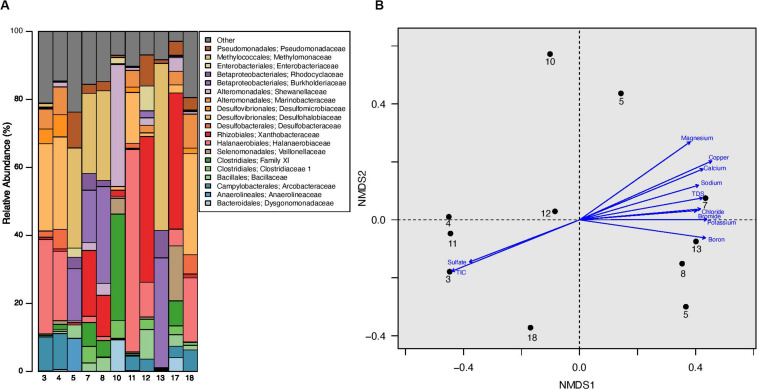
(A) Relative abundance of microbial families in produced water samples obtained from well separators. All families that represent = 5% of sequences from any one sample are listed in the barplot, all other families are grouped together under “Other.” (B) Non-metric multidimensional scaling (NMDS) plot of produced water samples with a stress value of 0.0720. This plot was constructed using Bray-Curtis distance calculated after sequence libraries were resampled to the depth of the sample with the fewest sequences from this experiment (1942 sequences). There was no significant clustering by well formation or well age (ANOSIM p > 0.05 for both), however, a Mantel test demonstrated a significant correlation between the microbial community and associated geochemical profile (R = 0.2336; p = 0.0430). Environmental vectors for geochemical parameters were fit onto the ordination plot, with the direction of the arrow corresponding to the direction of the gradient and the length of the vector proportional to the strength of the correlation between ordination and environmental variable. Only environmental vectors with a significant p-value (p < 0.05) are displayed; an NMDS plot with all environmental vectors as well as a table containing the R2 and p-values for the corresponding vectors is located in Supplementary Figure 6. In this figure, TIC refers to Total Inorganic Carbon (TIC).